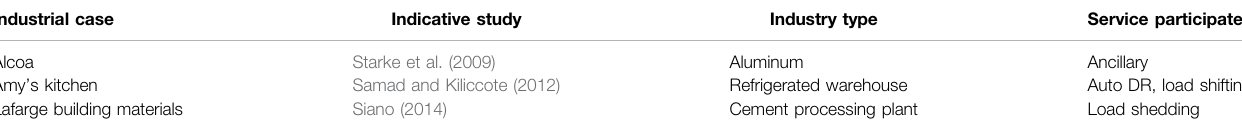
TABLE 6 | Industry-speci fi c case studies reported in